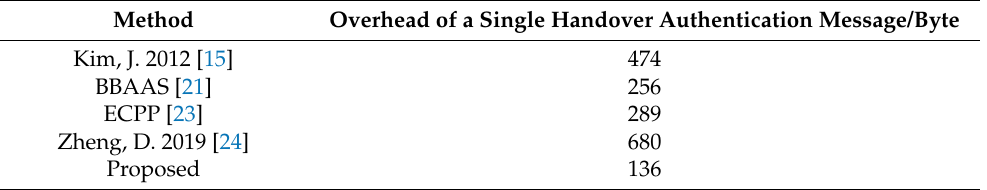
Table 3. Comparison of communication overheads.